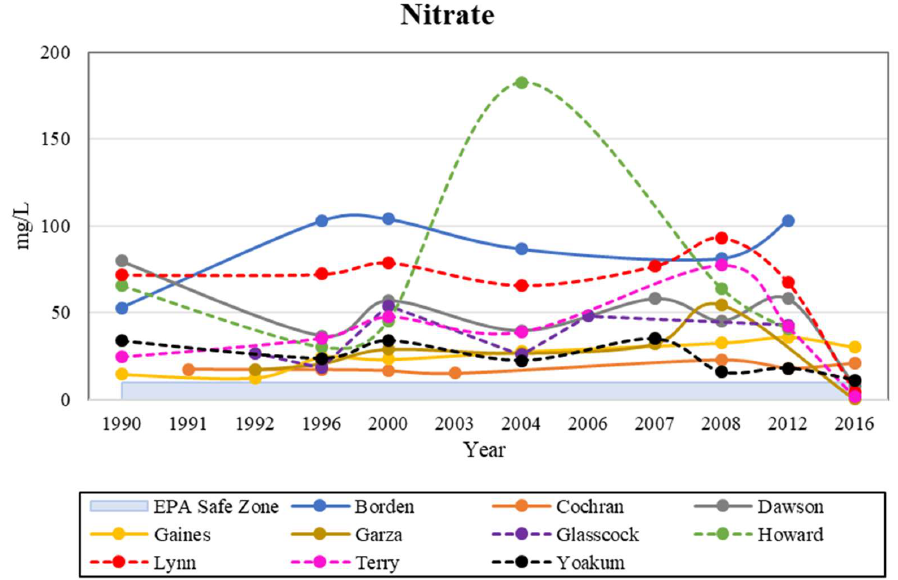
Figure 6. Historical analysis of nitrate levels in the study area, with the EPA safe zone shown for